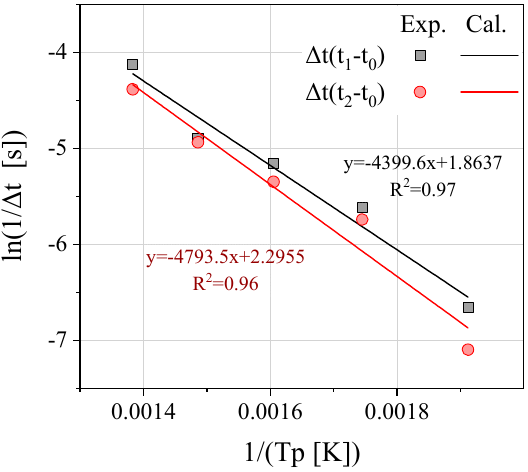
Figure 5. Linear relationships of ln ( 1/ ∆ t ( t 1 − t 0 )) and ln ( 1/ ∆ t ( t 2 − t 0 )) according to 1/ T P